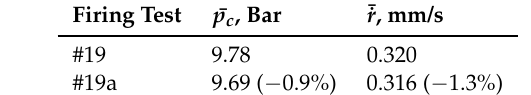
Table 7. Computed average results for Firing Test #19 with the effect of a change in the pre-exponential constant, Case #19a.